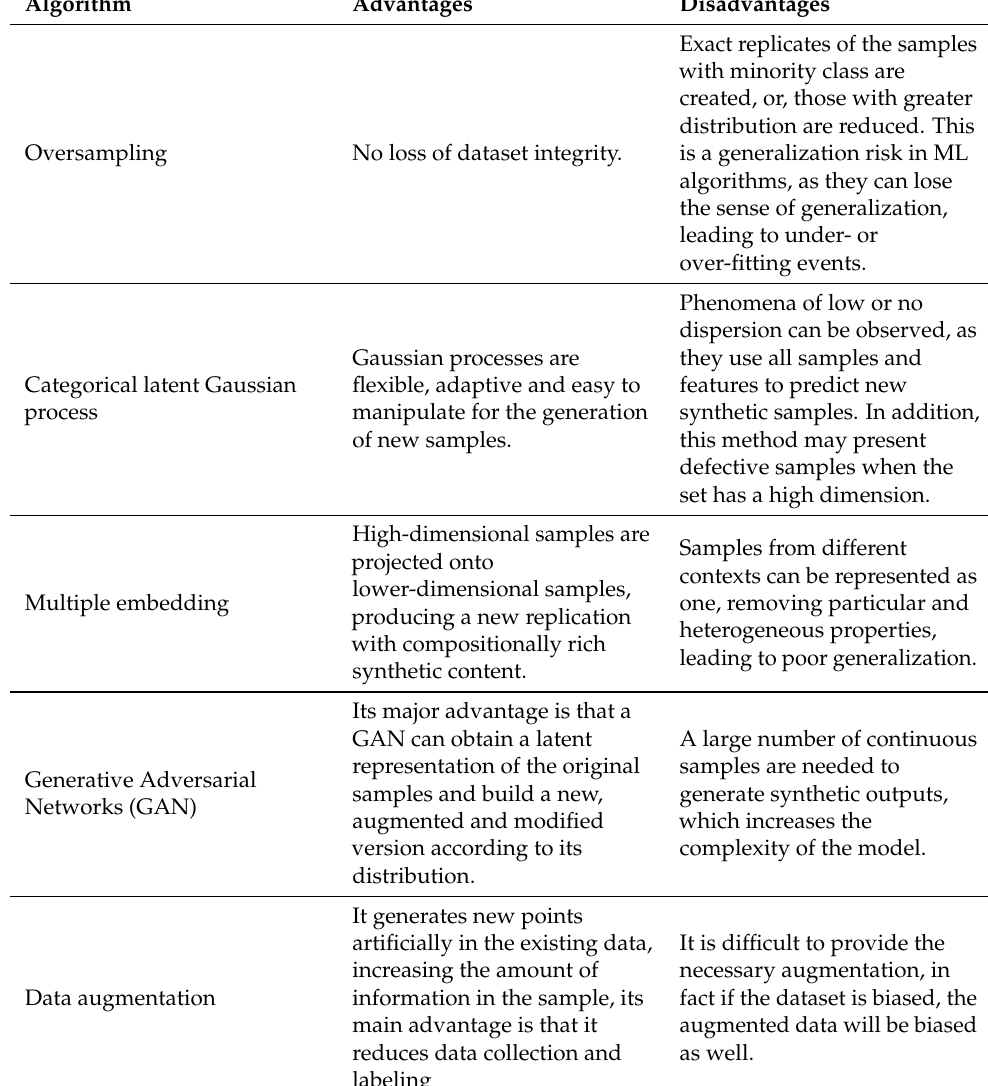
Table 1. Techniques and algorithms commonly used for the generation of synthetic